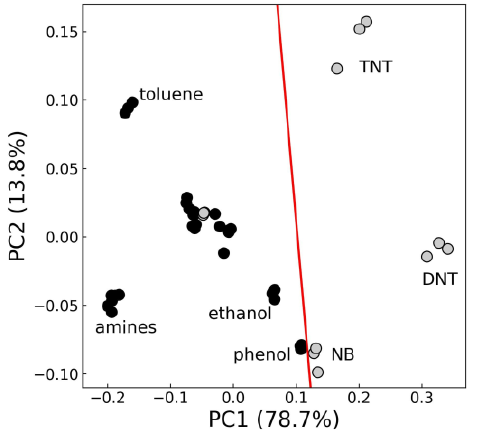
Figure 12. Two first principal components for the data of I exp and I recov metrics for materials mF+PS, mF/Elsp for nitroaromatic (gray markers) and non-nitroaromatic (black markers) analytes.